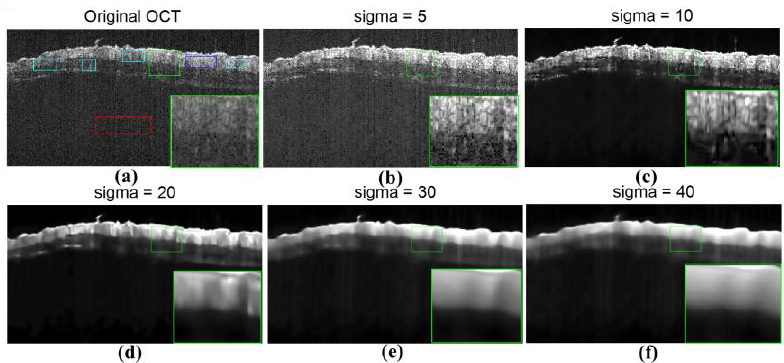
Figure 4. Noise reduction with different estimations of the noisy standard deviation ( σ ). ( a ) The original OCT image of the normal skin tissue in vivo. ( b – f ) Denoised OCT images with different estimations of the noisy standard deviation ( σ = 5, 10, 20, 30, and 40).